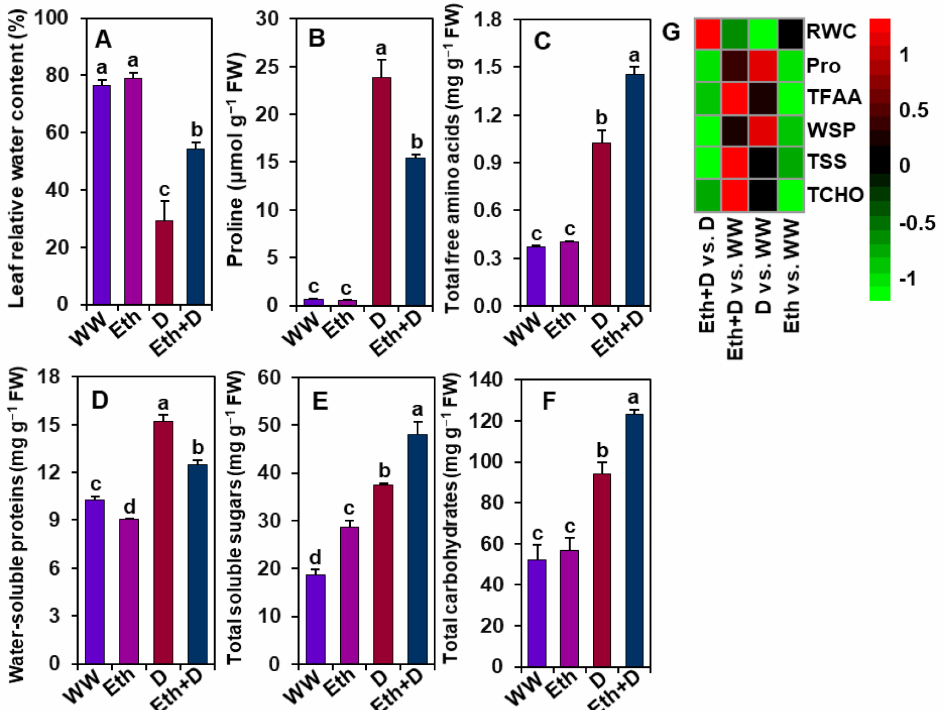
Figure 6. Effect of exogenously supplied 20-mM ethanol on the levels of ( A ) leaf relative water content, ( B ) proline, ( C ) total free amino acids, ( D ) water-soluble proteins, ( E ) total soluble sugars, and ( F ) total carbohydrates of soybean plants subjected to drought stress for a period of 8 days. ( G ) Heatmap of the fold-change values of the aforementioned parameters in soybean plants under different treatments. Bars represent means with standard errors ( n = 4). Different letters shown above the bars are used to indicate significant differences among the treatments ( p < 0.05). WW, Eth, D, and Eth + D indicate water-sprayed well-watered plants, ethanol-sprayed well-watered plants, water-sprayed drought-exposed plants, and ethanol-sprayed drought-exposed plants, respectively. FW, fresh weight; Pro, proline; RWC, relative water content; TFAA, total free amino acids; TSS, total soluble sugars; TCHO, total carbohydrates; WSP,